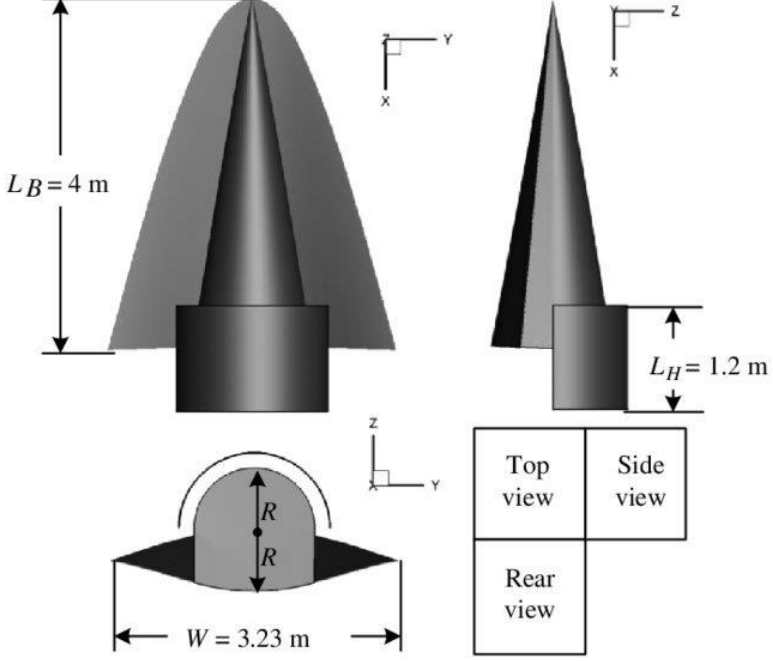
Figure 11. Three-view of a waverider-HCW combination configuration [23].